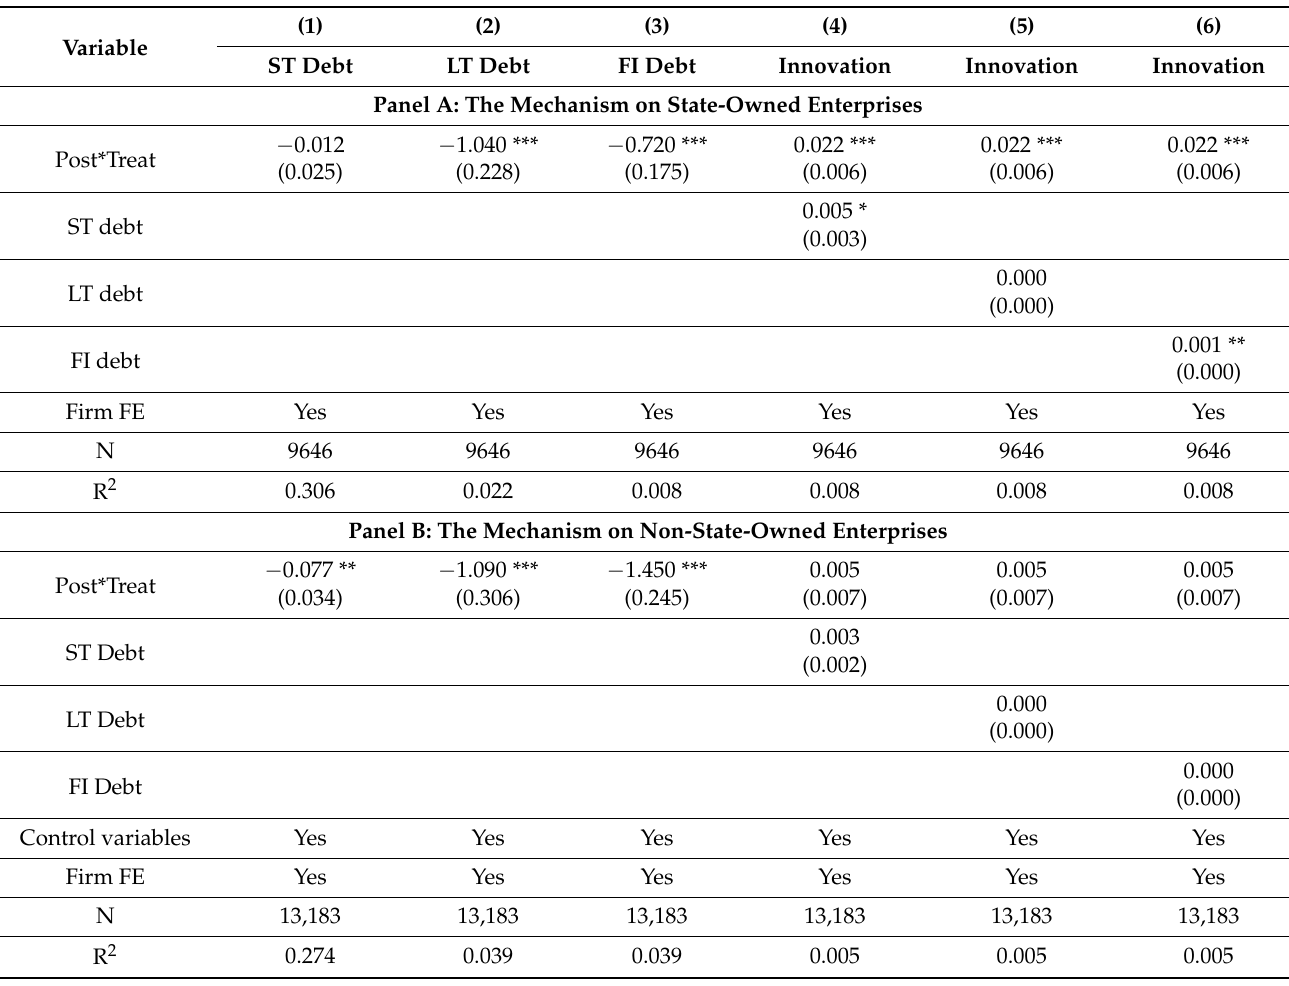
Table 9. Analysis on the influence mechanism in state-owned enterprises and non-state-owned enterprises.